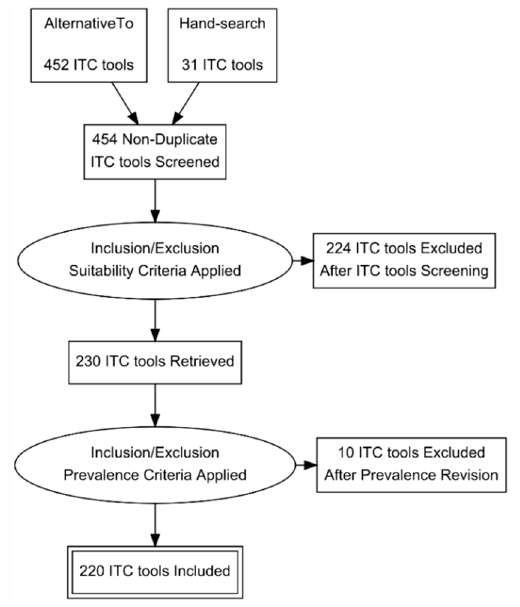
Figure 2. Assisting software search strategy.